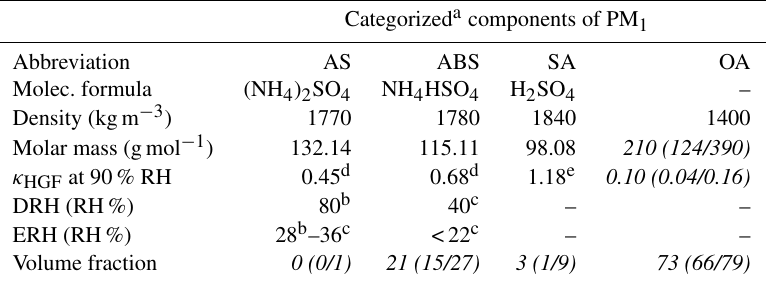
Table 1. Literature values of density, molar mass, deliquescence point (DRH), efflorescence point (ERH) and hygroscopicity κ for inorganic species. Hygroscopicities of inorganics listed here are based on the E-AIM model (Clegg et al., 1998). Variables written in italic style are campaign medians with quartiles in the